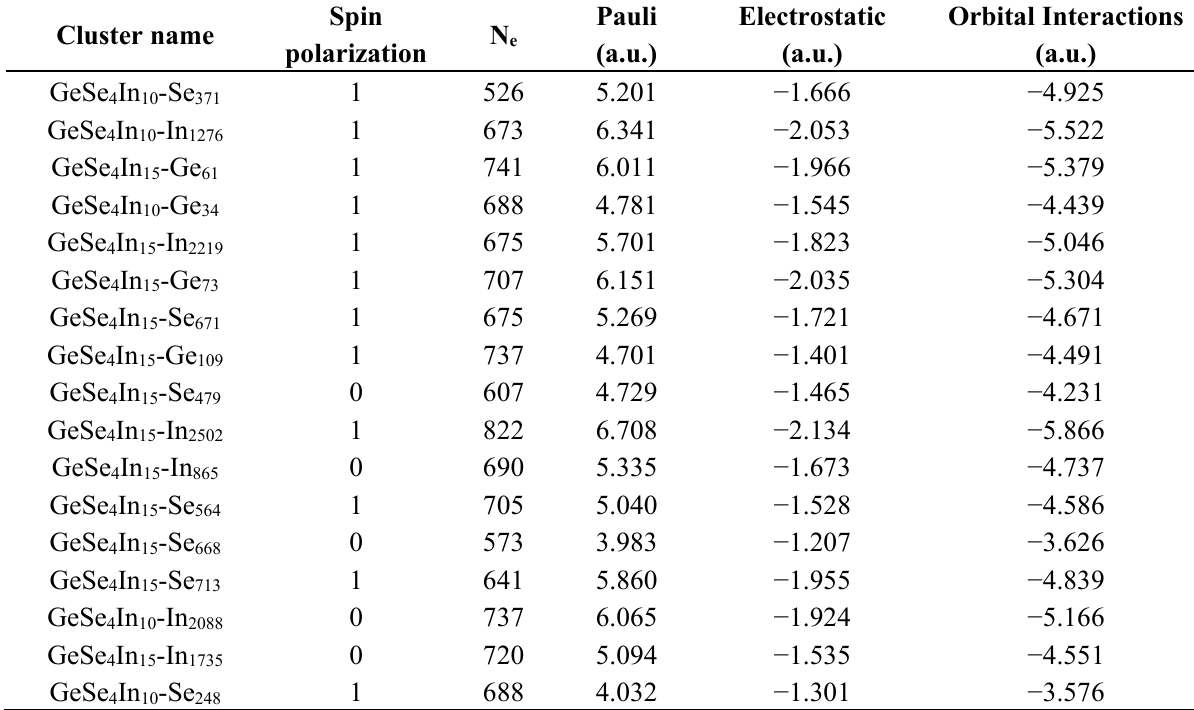
Table 4. Spin polarization, number of electrons, N e , and binding energy decomposition for the clusters